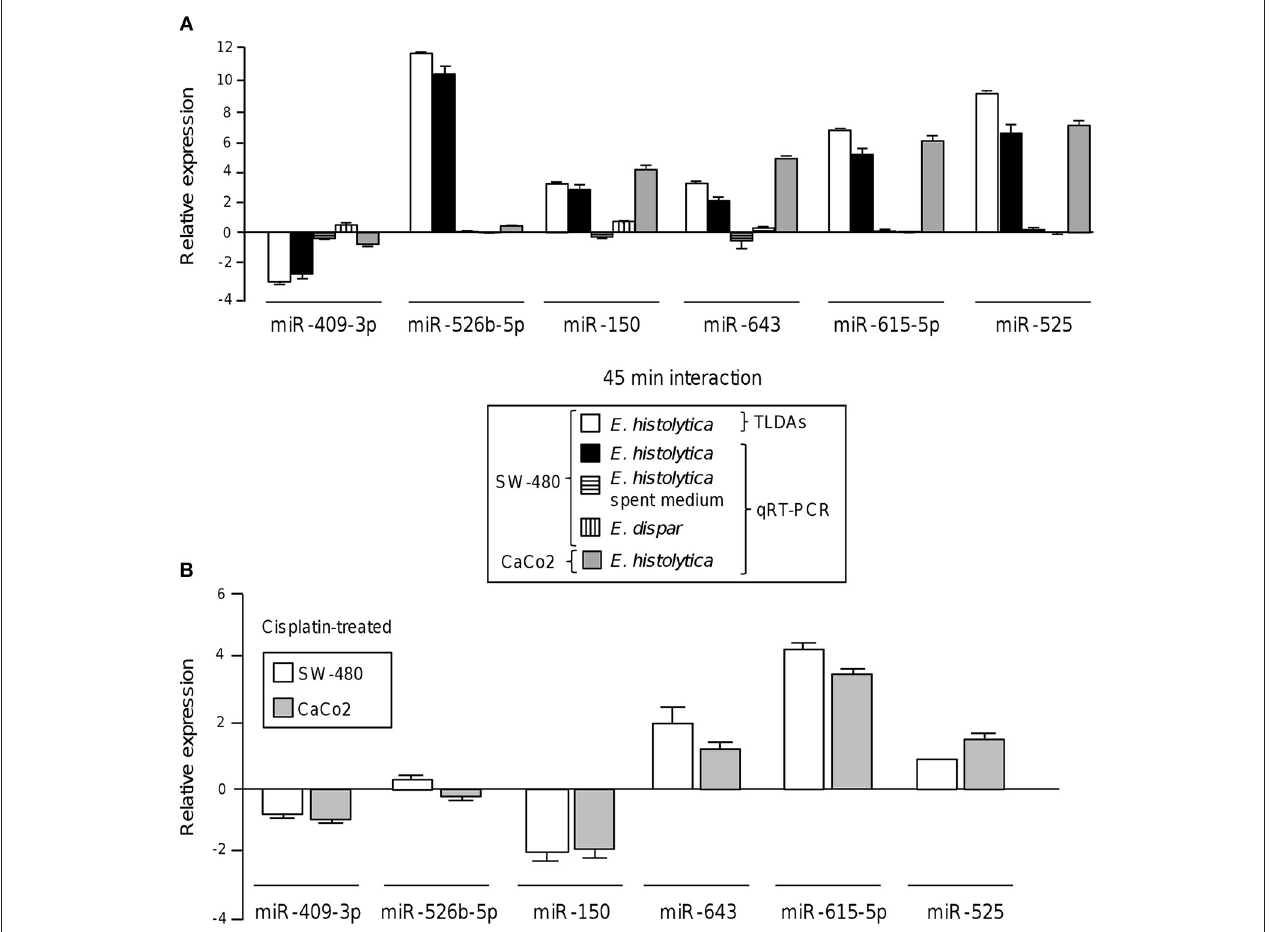
FIGURE 2 | Validation of differential expression of cellular miRNAs after interaction of colon cells with trophozoites. (A) Expression levels of the 6-miRNAs signature during the interplay of SW-480 cells with E. histolytica for 45min using qRT-PCR assay (black bars) in comparison with data obtained using spent E. histolytica media, during interaction of Entamoeba dispar parasites with SW-480 cells and relative to TLDAs profiling (white bars). qRT-PCR assays of Caco2 cells interacting with trophozoites were carried out as an additional control (gray bars). Cell lines, treatments and experiments performed for the 6-miRNAs profiling are denoted in the box inset. (B) qRT-PCR assays of the 6-miRNAs in SW-480 and Caco2 colon cells treated with cisplatin as apoptosis control for 24h. Data is representative of three independent experiments that were performed in duplicate, error bars represent